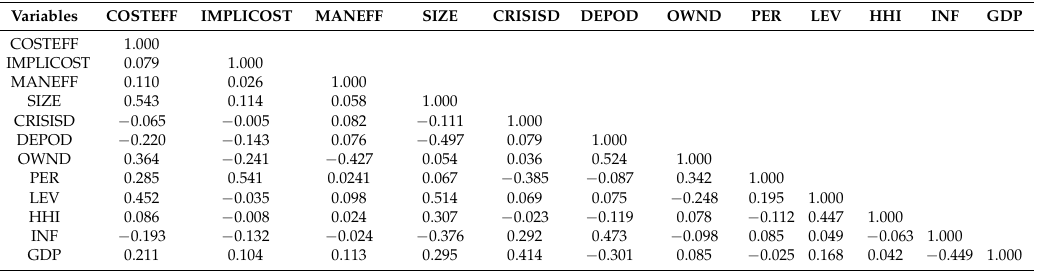
Table 3. Pearson’s Correlation Coefficient.